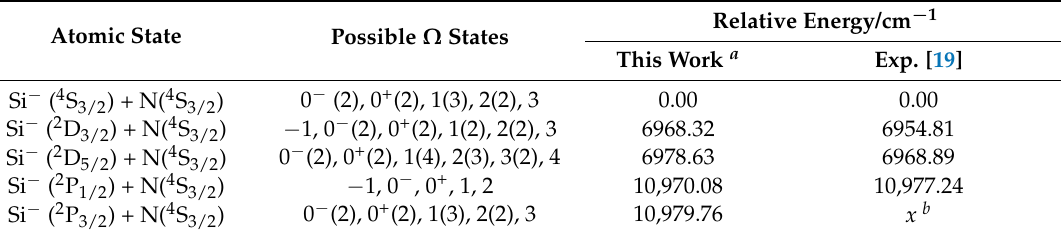
Relative Energy/cm −